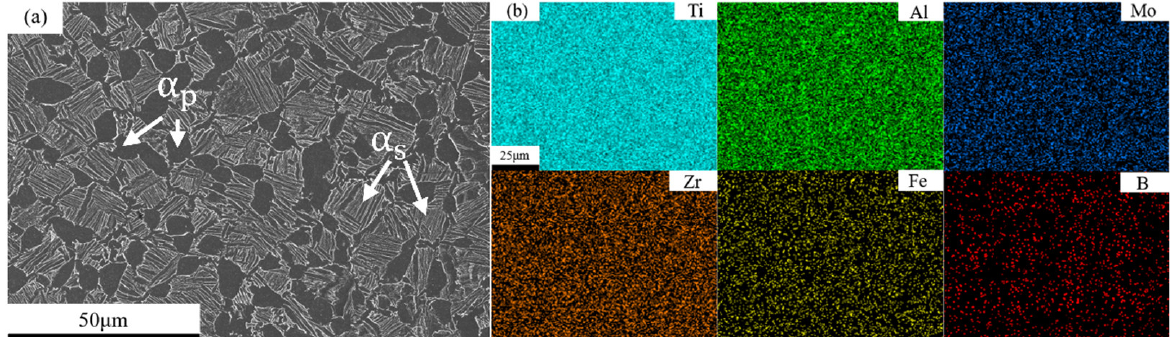
Figure 1. SEM results: ( a ) microstructure and ( b ) composition distribution maps of the Ti-6Al-1Mo- 2Zr-0.55Fe-0.1B alloy.